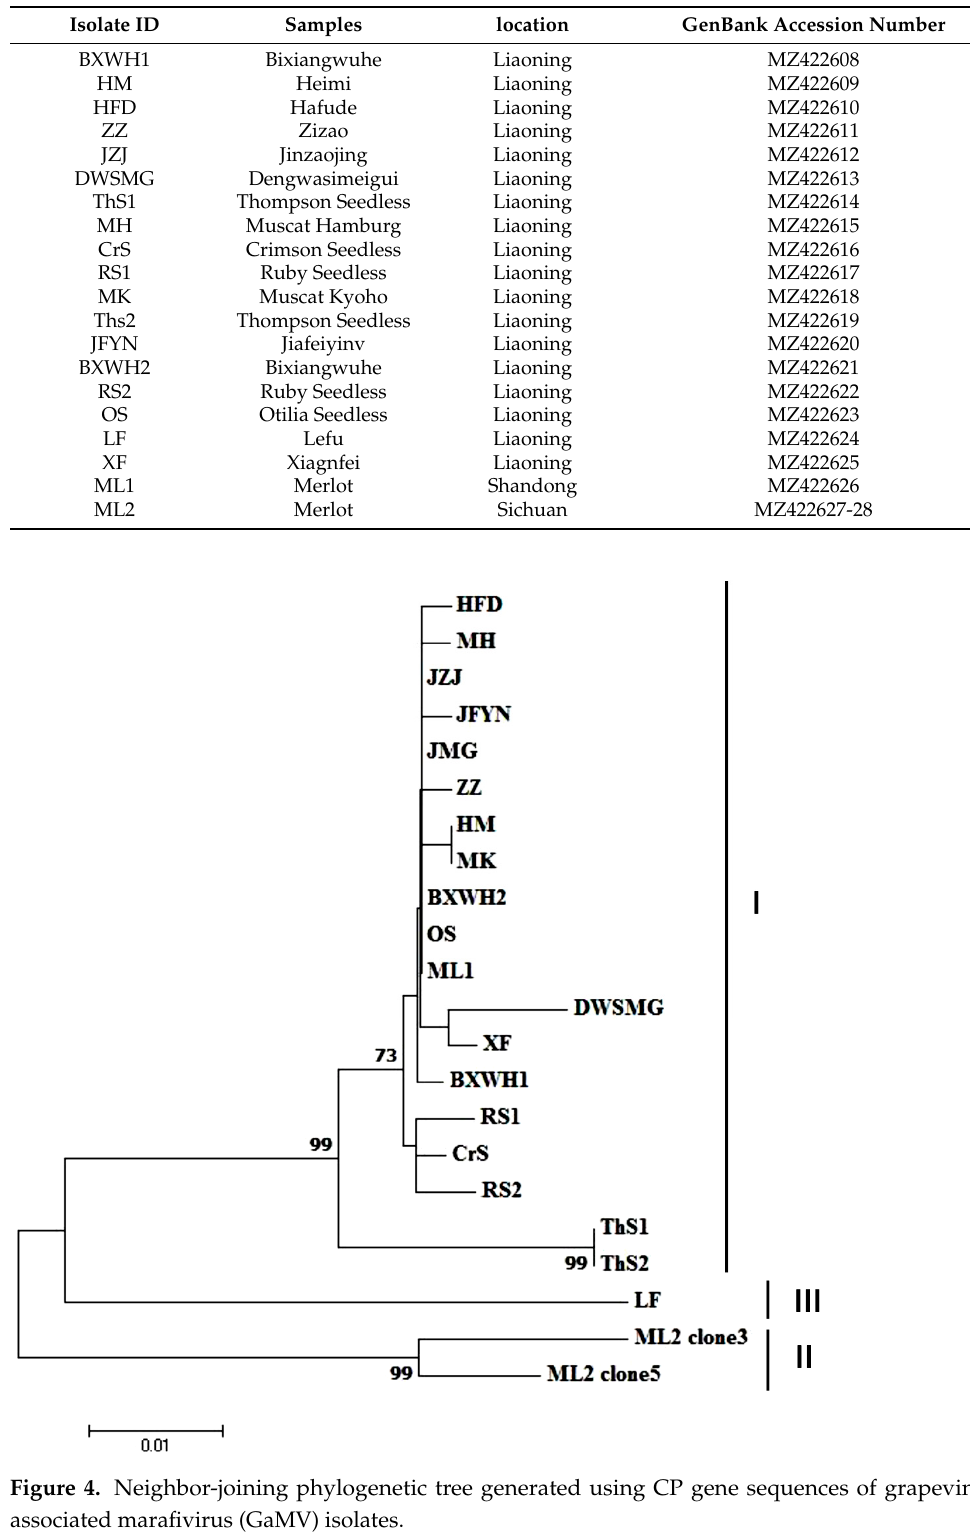
Table 2. Details of grapevine-associated marafivirus (GaMV) isolates generated and analyzed in this study.